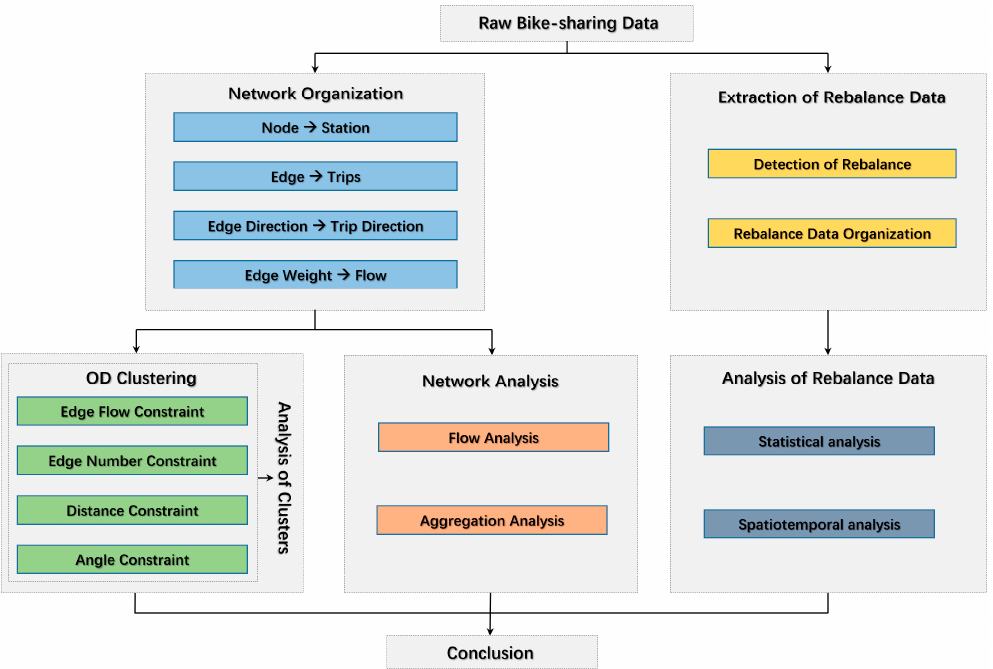
Figure 2. The method framework of our